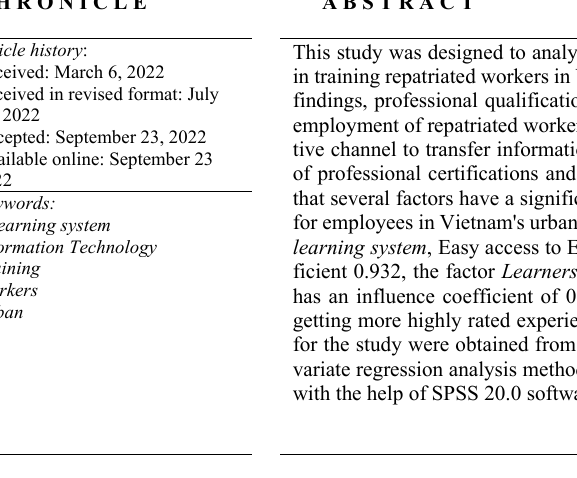
Rate of informal employment in The proportion of working in high-risk fields (%) non-agriculture